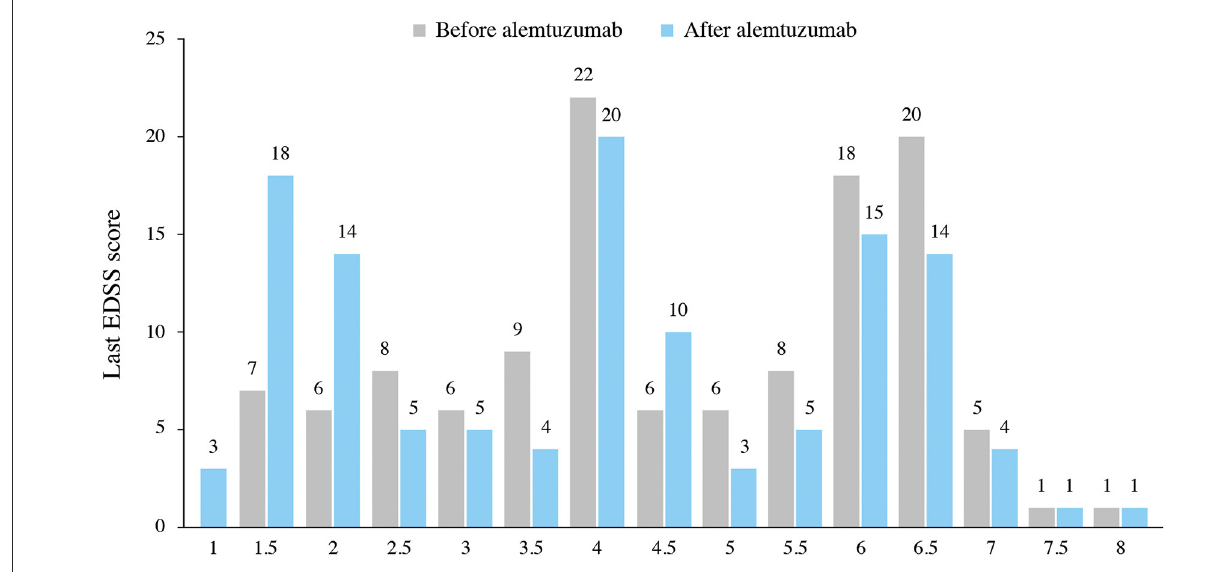
FIGURE3 Distribution of EDSS categories.